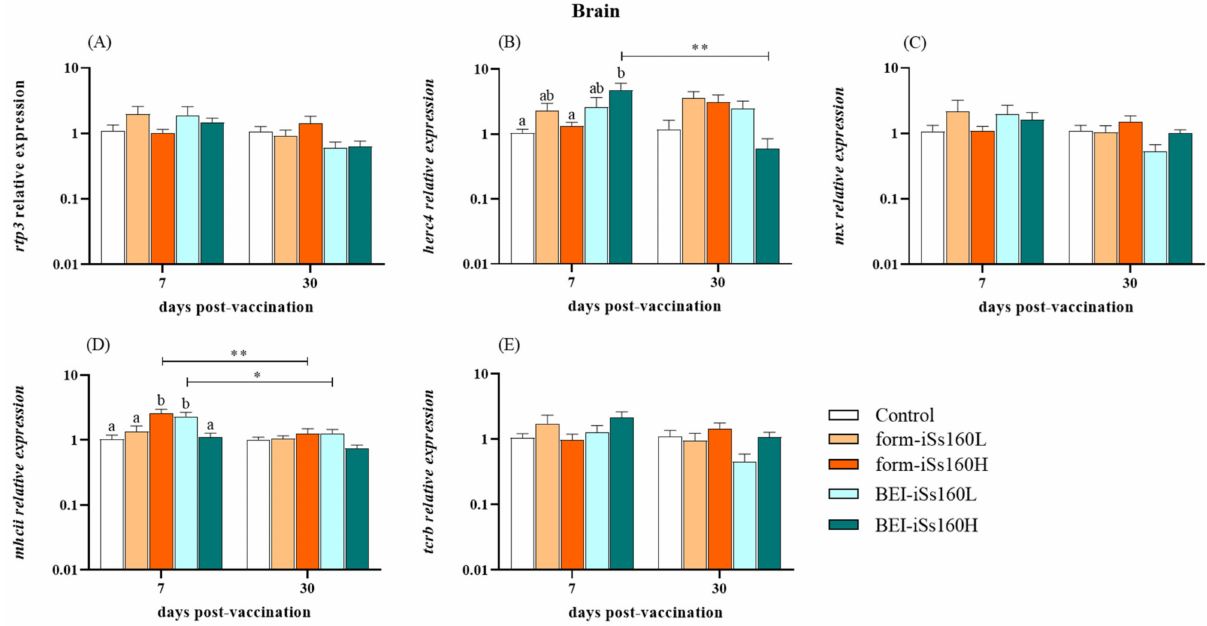
Figure 3. Vaccination barely alters the immune response at transcriptional level in brain. Expression of immune-related genes ( A ) rtp3 , ( B ) herc4 , ( C ) mx , ( D ) mhcii and ( E ) tcrb in the brain of Senegalese sole specimens 7-, 15- and 30-days after intraperitoneal vaccination with low and high dosages (10 5 and10 7 TCID 50 /mL, iSs160L and iSs160H, respectively) of BEI-iSs160 vaccine (inactivated with BEI) and form-iSs160 (formalin inactivated) or PBS (Control). Data represent the mean ± standard error of the mean (SEM; n = 6 fish/group and time). Lower letters denote statistical differences between groups at a same time-point ( p < 0.05), whilst asterisks indicate those between time-points in the same group (* p < 0.05; ** p <